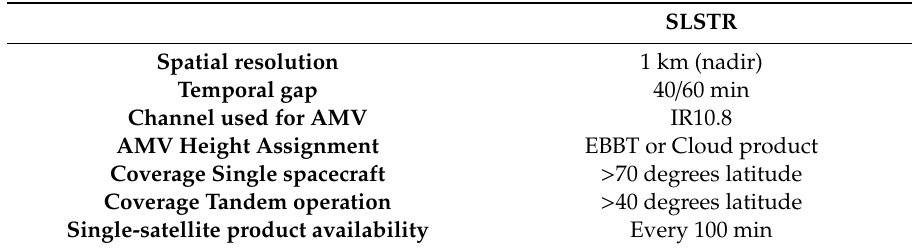
Table 4. Upcoming Sentinel-3 Sea and Land Surface Temperature Radiometer (S3 / SLSTR) AMV product characteristics.